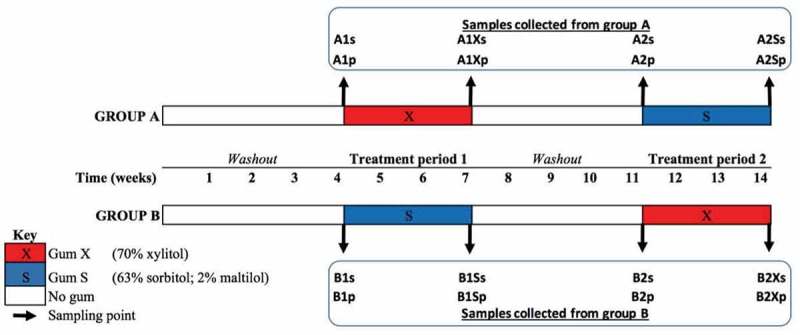
Study design. After the initial washout period, study group A was treated with gum X and group B with gum S for three weeks, followed by a second washout before treatment period 2 when group A was given gum S and group B was given gum X. Samples collected before and after each treatment period were coded according to group (A/B), the treatment period (1/2), the gum used (X/S) in the case of those samples collected at the end of a given treatment period and according to whether the sample was saliva (s) or plaque (p).